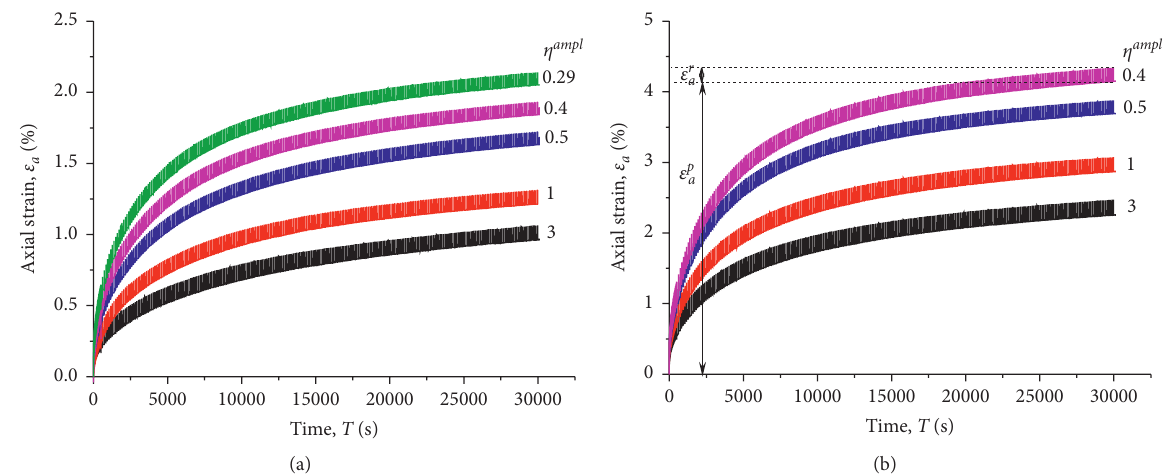
Figure 5: Typical time-history curves of axial strains: (a) CSR � 0.278; (b) CSR � 0.486.